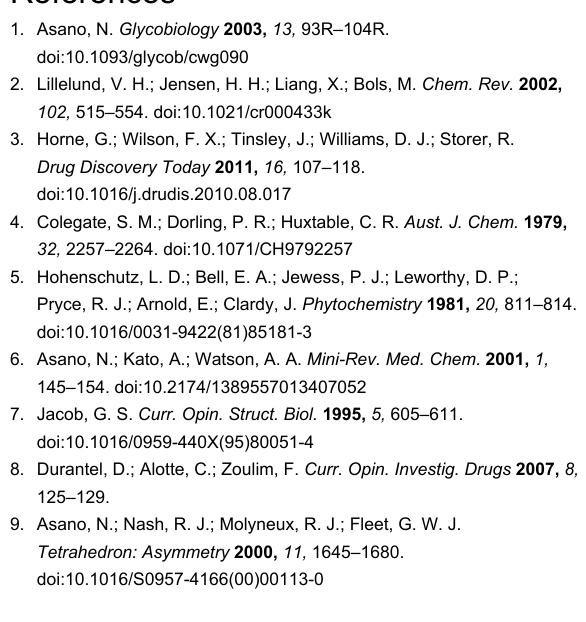
derivatives of potential importance, 18 , 23 and 24 in